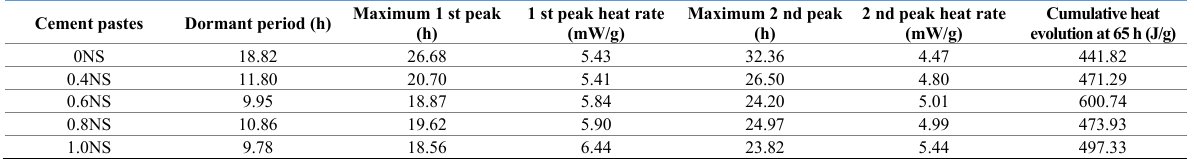
Table 5. Calorimetric parameters for cement pastes with NS. Cement pastes